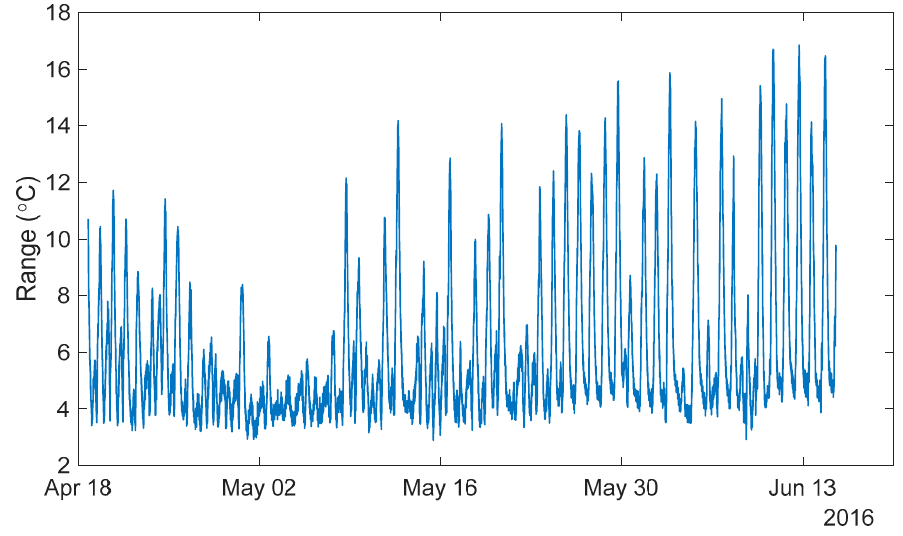
Figure 8. Range of temperature measurements from spring 2016. Table 1. Number of time periods identified by Maximum Range